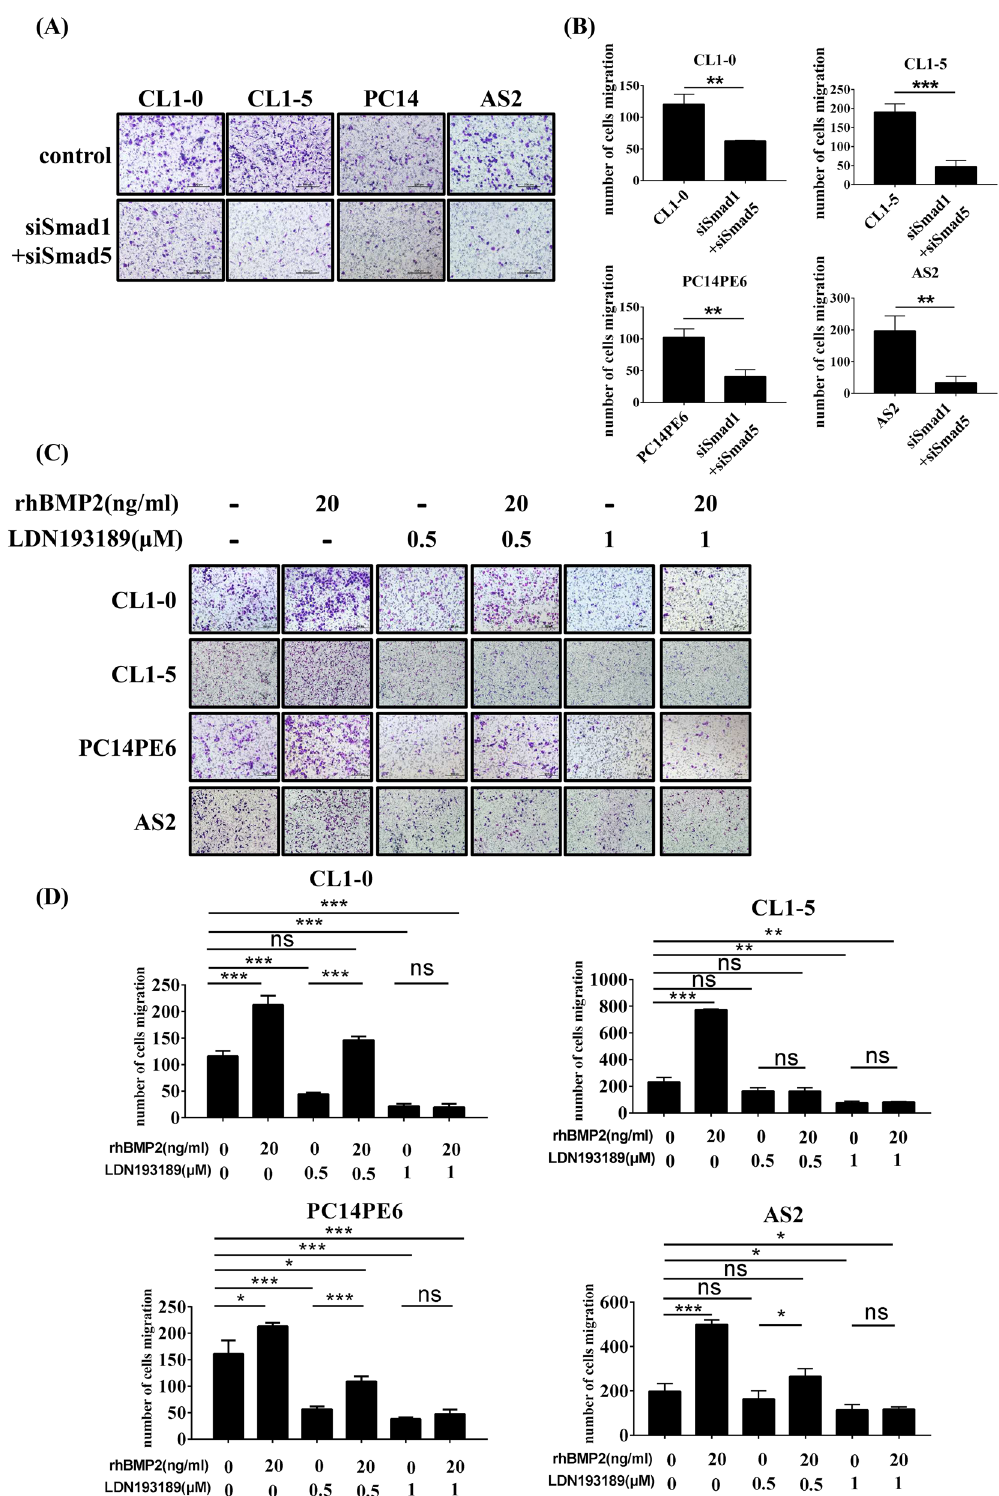
Figure 5. The depletion or inhibition of SMAD pathway attenuates lung cancer cell migration. ( A ) The cell migration abilities were reduced in SMAD1/5-depleted cells. Slides were observed under 10 × magnification. ( B ) Quantitative data derived from ( B ). Bar graphs represent the average number of migrated cells ± SD. At least three fields were counted for each condition. ( C ) Representative images of cell migration for each cell line. Cells were treated with 20 ng/ml rhBMP2 with or without BMP signaling inhibitor LDN193189 as indicated. Slides were observed under 10 × magnification. ( D ) Quantitative data derived from ( C ). Bar graphs represent the average number of migrated cell ± SD. At least three fields were counted for each condition. The p -value was determined by Student’s t test (* p < 0.05, ** p < 0.01, *** p <